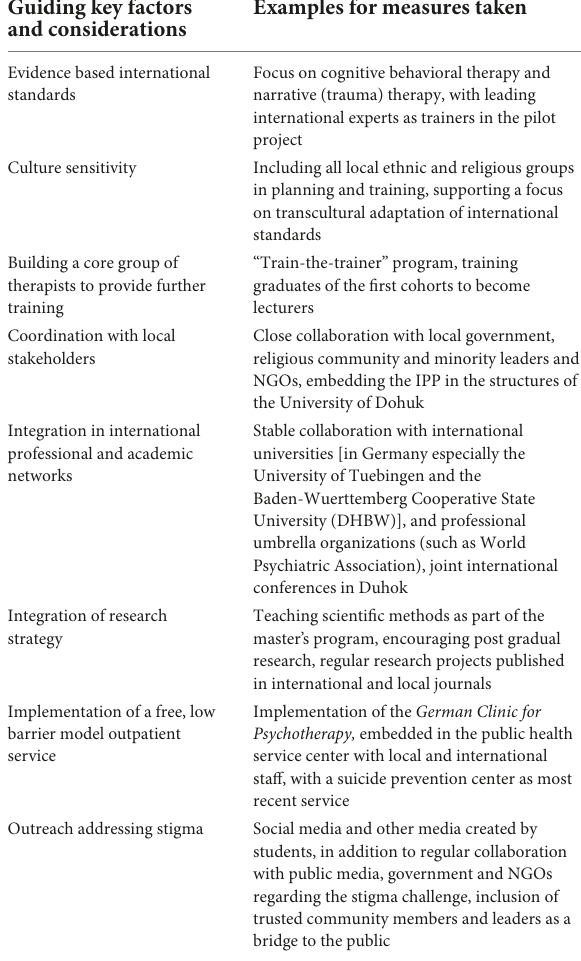
TABLE 3 Considerations and key factors that guided the development of the institute for psychotherapy and psychotraumatology with examples for their